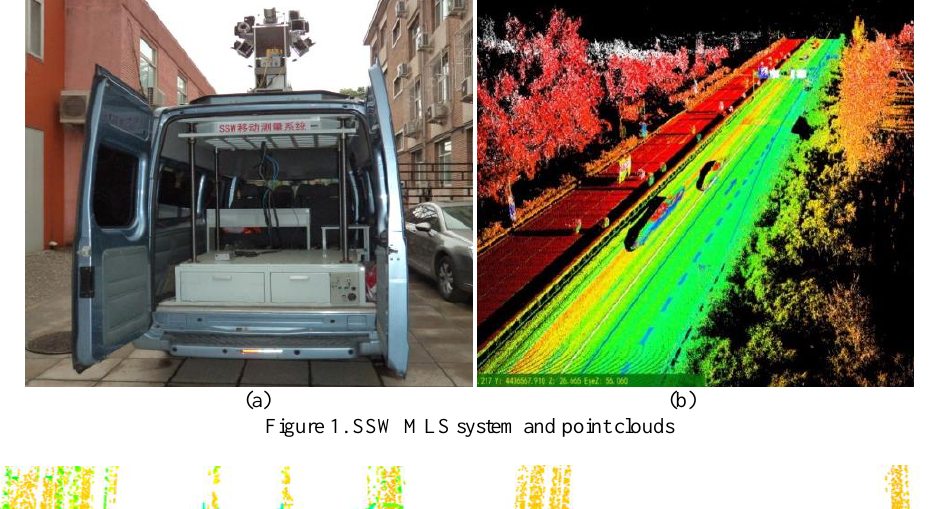
Figure 1. SSW MLS system and point clouds